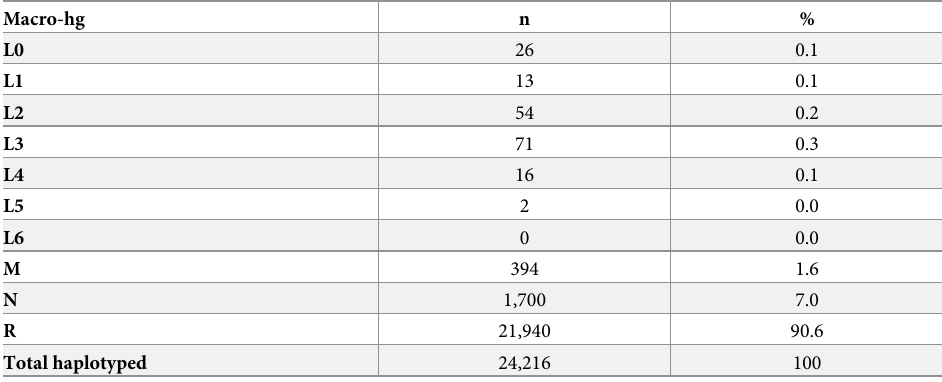
Table 1. Distribution of mtDNA macro hgs L0-L6, M, N and R. (see Materials and